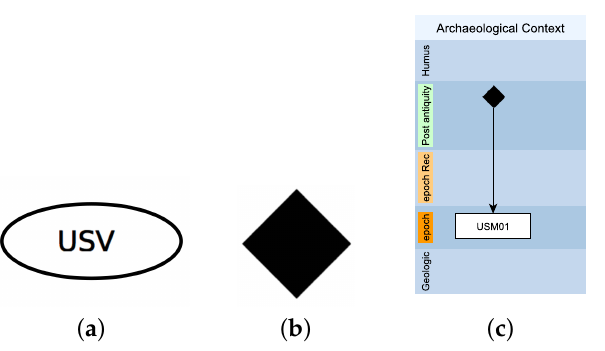
Figure 15. Nodes added to Extended Matrix 1.2: ( a ) seriation node for an extant US and ( b ) continuity node; ( c ) example of use of the continuity node linked to the US whose end of life it